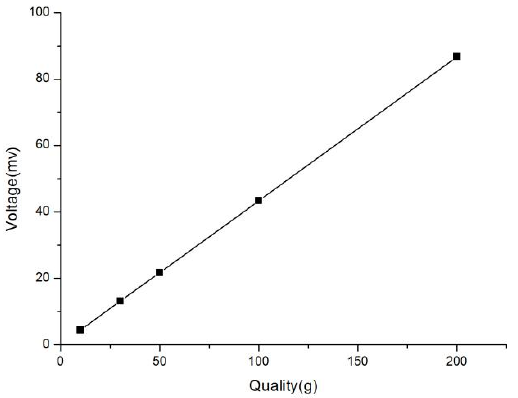
Figure 2. Variation curve of voltage value with weight of counterweight.